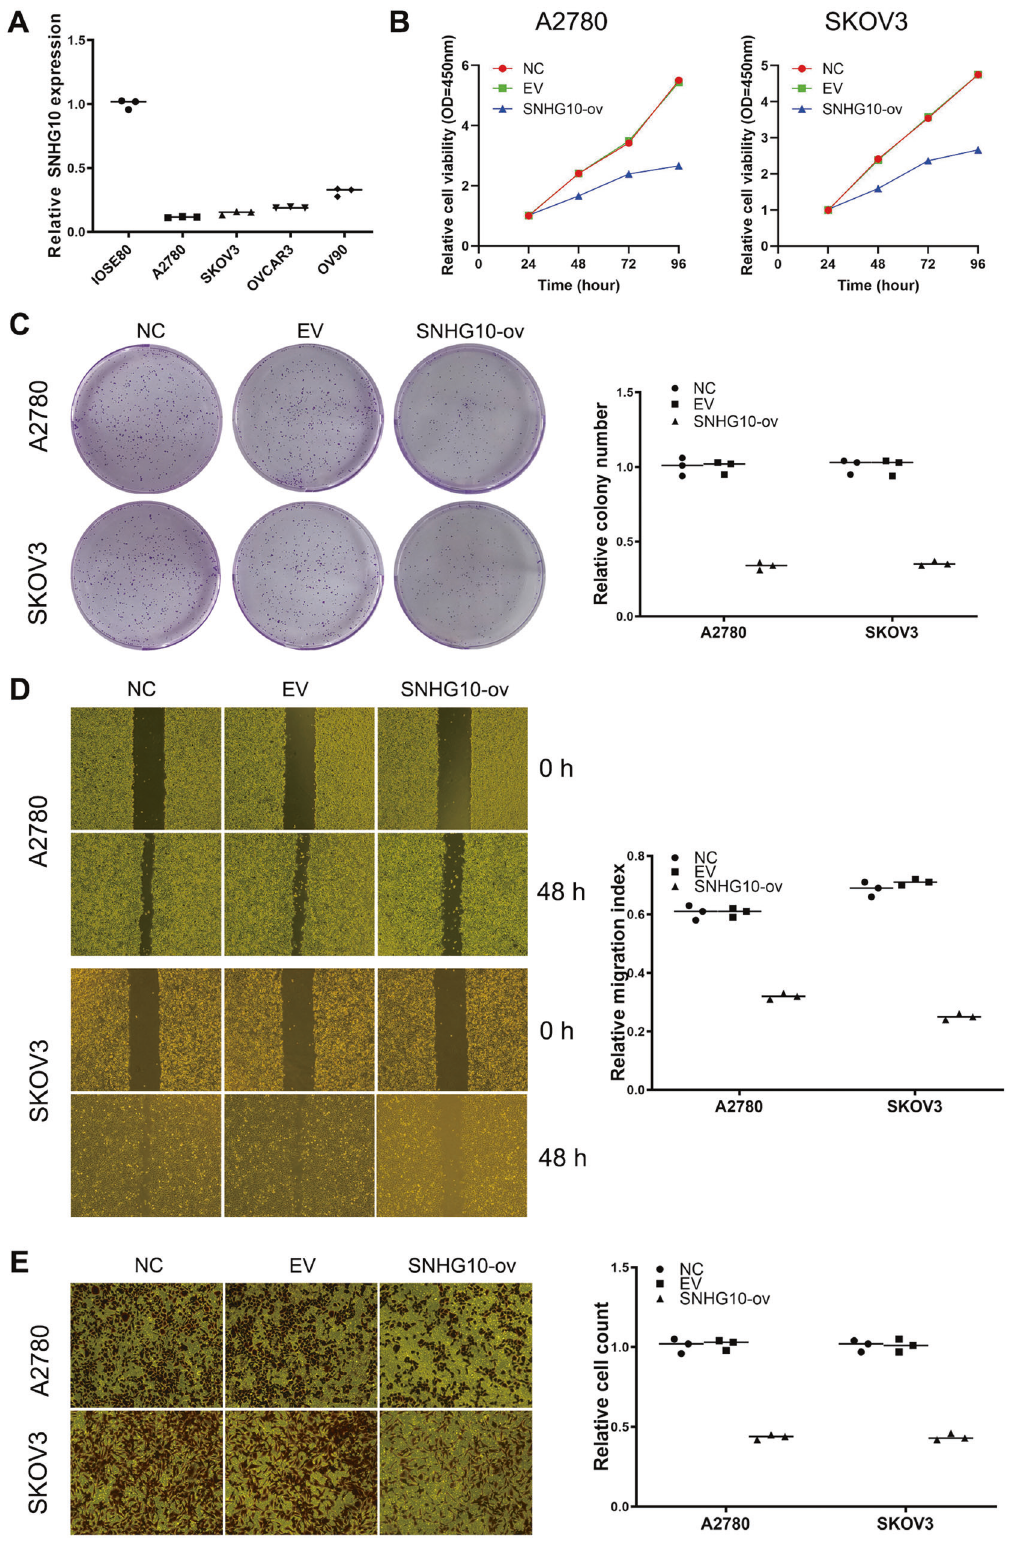
Fig. 2 SNHG10 overexpression suppresses the proliferation, migration, and invasion ability of EOC cells in vitro. A Expression of SNHG10 in EOC cell lines, assayed by qRT-PCR, normal ovarian epithelial cell line IOSE80. B SNHG10 overexpression suppressed proliferation ability of EOC cells, assayed by CCK-8 method. Plots indicate mean. C SNHG10 overexpression suppressed colony formation ability in EOC cells. D SNHG10 overexpression suppressed migratory ability in EOC cells, assayed by wound-healing experiment. E SNHG10 overexpression suppressed invasive ability in EOC cells, assayed by transwell. The experiments were conducted in triplicate.